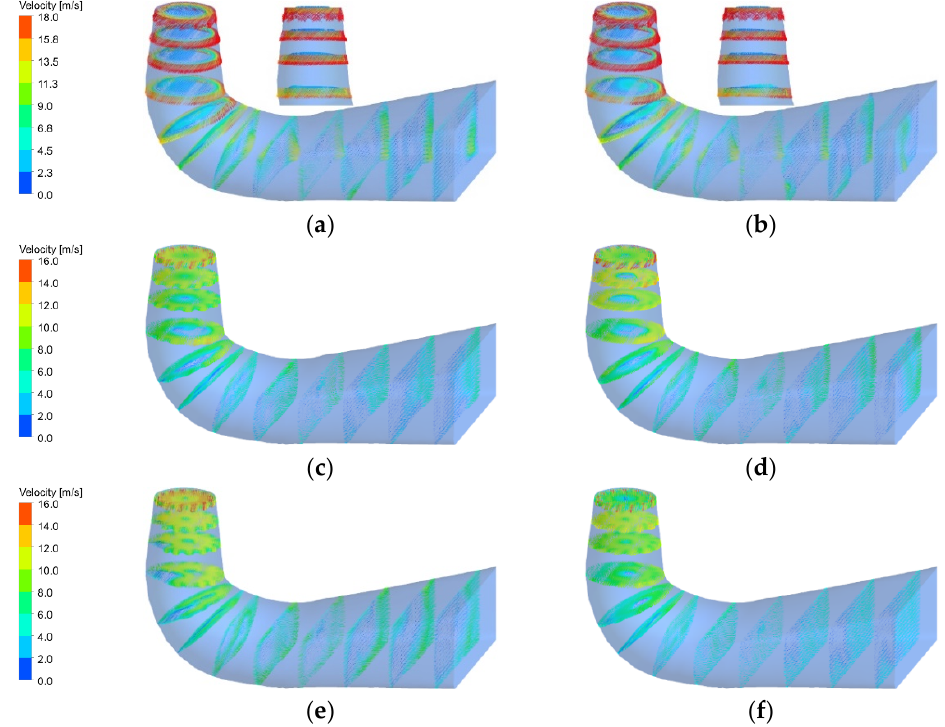
Figure 6. Velocity vectors at various sections of the draft tube. ( a ) OP1, ( b ) OP2, ( c ) OP3, ( d ) OP4, ( e ) OP5, and ( f ) OP6.